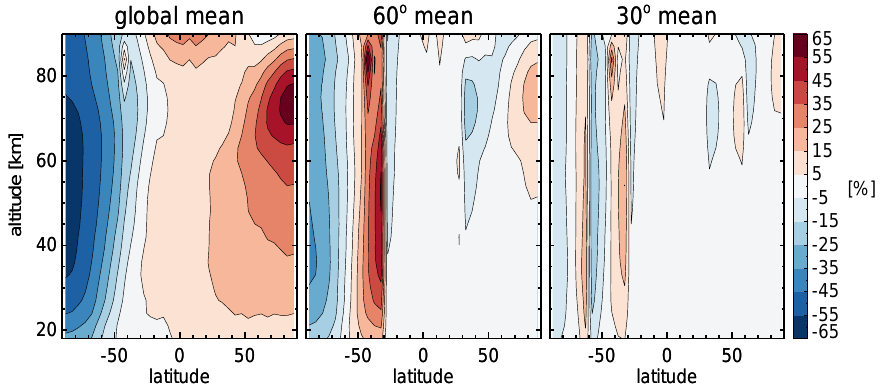
Fig. 6. Pressure variation of global (left), 60 ◦ (middle) and 30 ◦ (right) latitude bin profiles for the MIPAS MA mode days available in June, July and August 2007, 2008 and 2009.